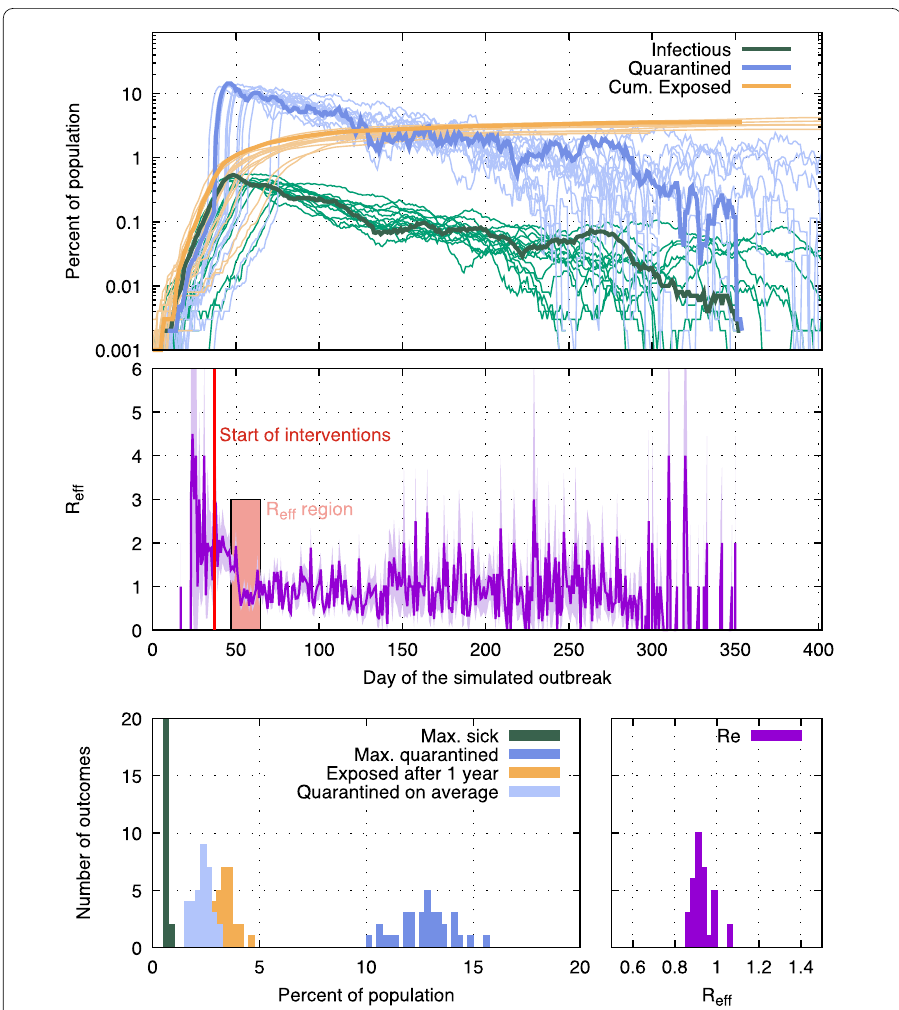
Figure 6 Stochastic variation in outbreak dynamics. The results are from 50 runs of the MC simulation; each run has the same input parameters ( p app = 0.9, α · f m = 0.95, η as = 1, trace uninfected = true). Top: The fraction of infectious (green), quarantined (blue) and cumulative exposed (yellow) people for each day of the simulated outbreak. Curves for only 20 out of the 50 runs are shown to improve legibility. Outcomes from one selected run are drawn as bold lines. Middle: R e each day is shown for the MC run drawn in bold in the top plot. The red vertical line indicates the time when 0.4% of the population have been infected, which is when interventions (other than quarantining of reported symptomatic cases, which is enabled from the beginning) are turned on. To measure their effectiveness, R e is averaged over 18 days (red area), starting 10 days after interventions commence. Bottom: Outcomes from the 50 MC runs, such as the maximum fraction of the population quarantined, are histogramed to show the statistical variation more clearly